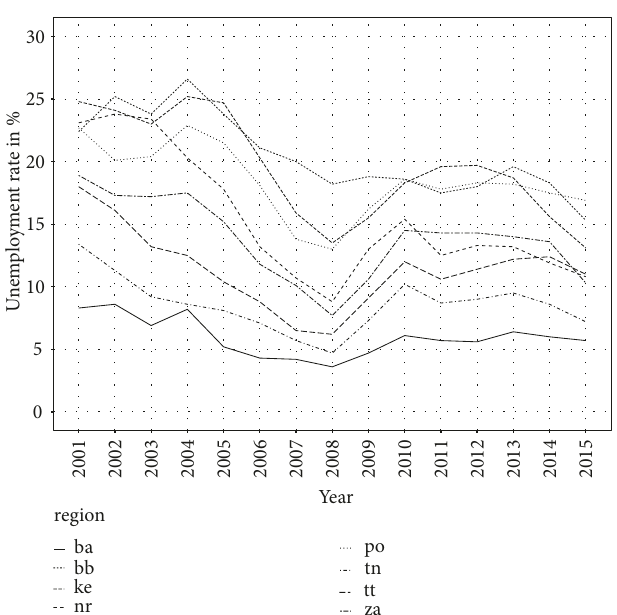
Figure 6: Unemployment rate in Slovak